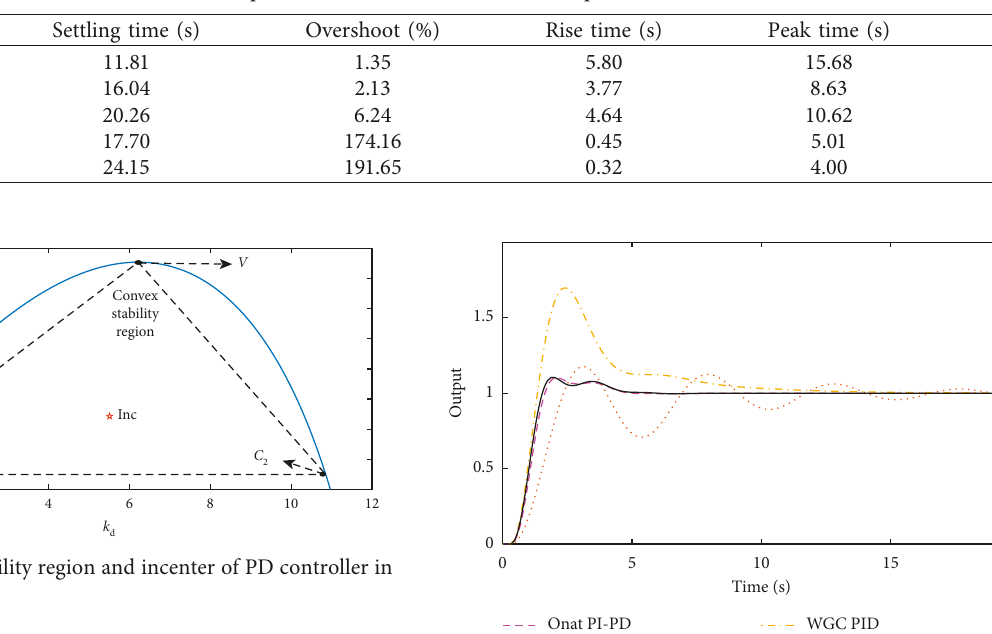
Table 2: Performance metrics comparison of various methods in example A (other data cited from [34]).